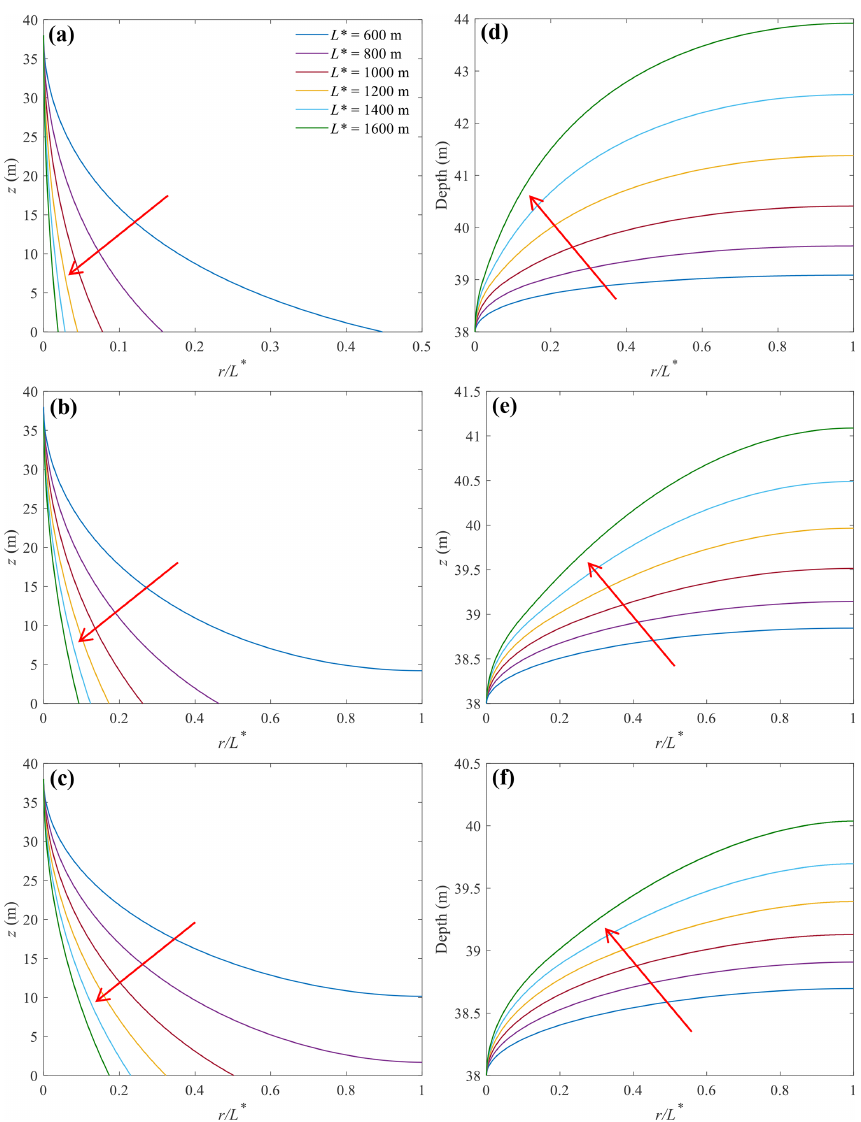
Figure 8. Sensitivity of (a–c) the locations of the freshwater–seawater interface and (d–f) watertable to L ∗ for convergent (a, d) , rectangu- lar (b, e) and divergent (c, f) aquifers. The arrow in each plot points to the increase in L ∗ values used to construct each curve (values indicated in a